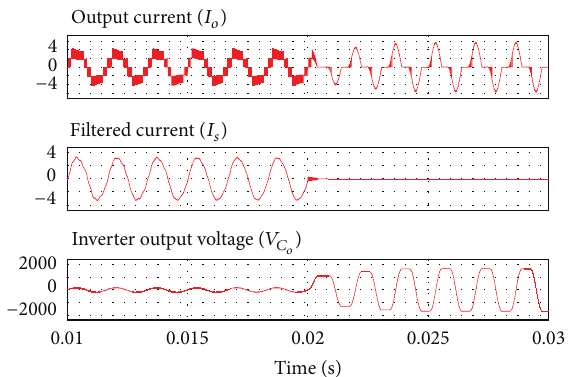
Figure 11: Operation of the system under a grid disconnection without the protection circuit. Top to bottom: output current ( 𝐼 𝑜 , 2A/div), filtered current ( 𝐼 𝑠 , 2A/div), and Inverter output voltage , 1000V/div). ( 𝑉 𝐶 𝑜